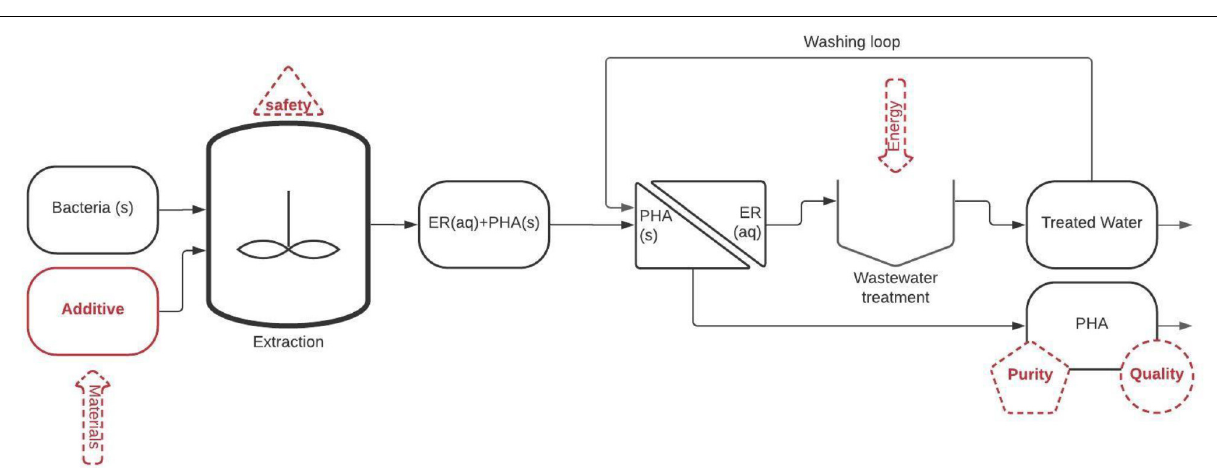
FIGURE 1 | General scheme representing the solvent-based approach for recovering PHA from PHA rich bacteria. AS, anti-solvent; S, solvent; PHA, polyhdroxyalkanoate; PHA (s), polyhydroxyalkanoate in suspended solid form; ER (s), extraction residue as suspended solids. *If the extraction is performed directly on wet microbial slurry. **If an anti-solvent is used.